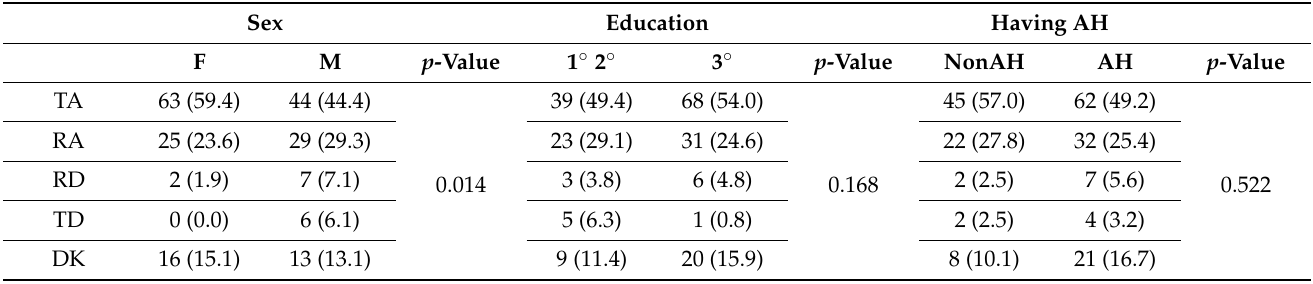
Table 4. Obesity as a factor that increases the incidence of hypertension by gender, education, and having hypertension (N = 205).